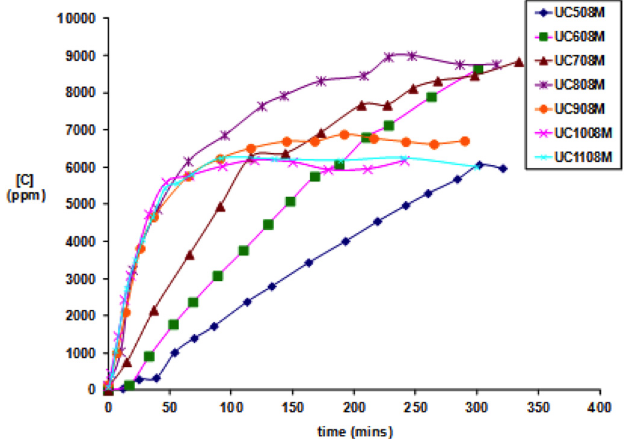
Fig. 4. The effect of temperature on the total carbon dissolved throughout the 70g UC pellet (right) dissolution. [HNO 3 ] ini = 8M (e.g. UC50 is 50 ° C and UC110 =110 ° C).